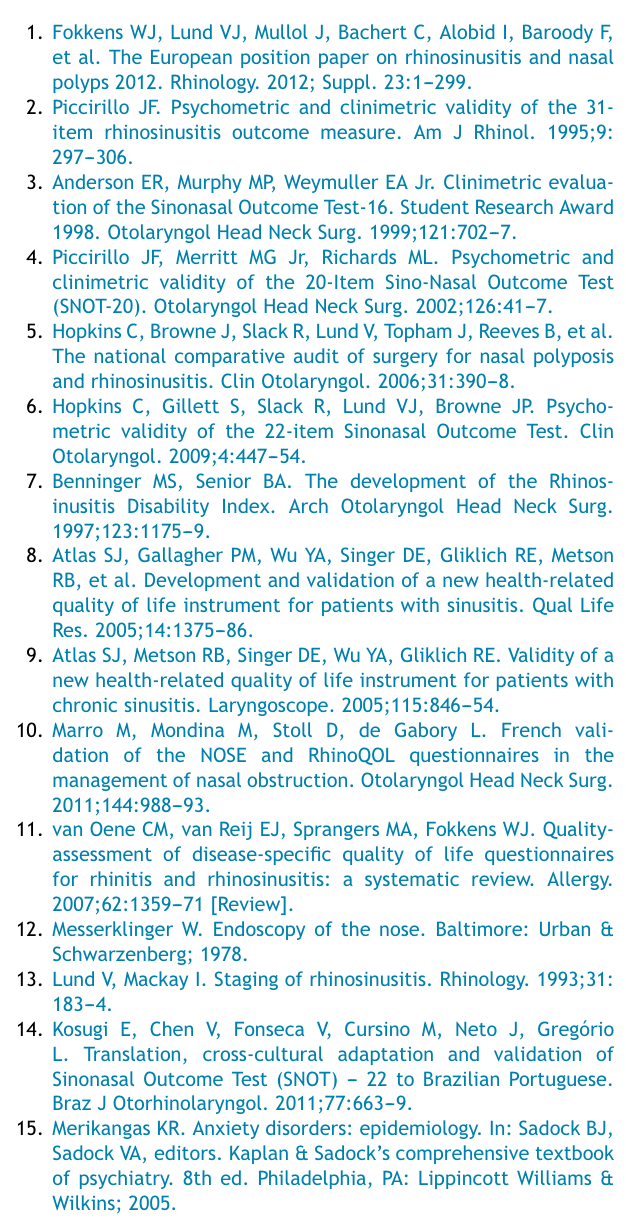
Internal consistency reliability --- Cronbach’s ˛